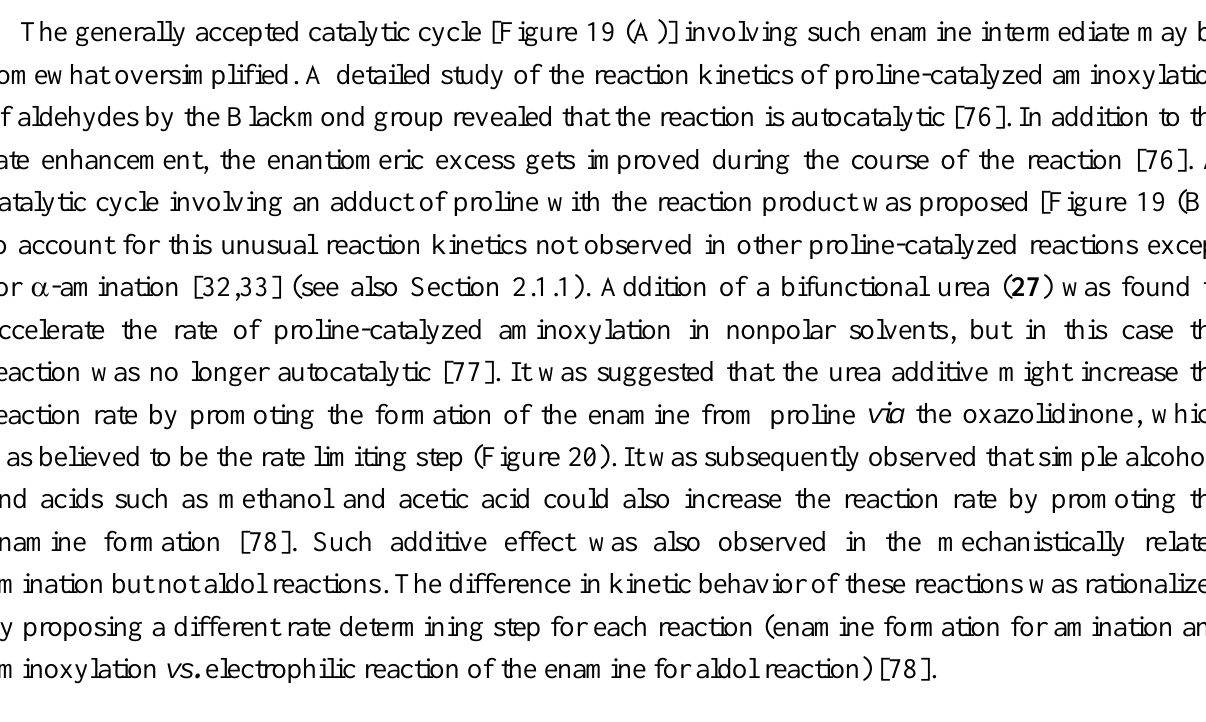
Figure 19. (A) The generally accepted catalytic cycle of proline-catalyzed aminoxylation of aldehydes; (B) The proposed autocatalytic model by Blackmond et al .